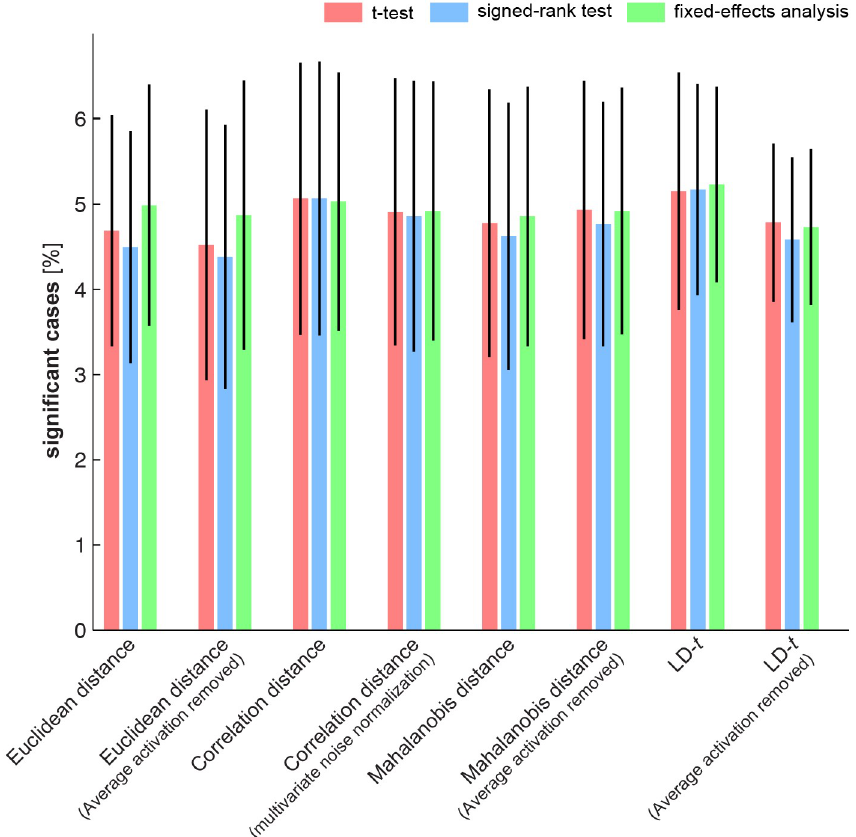
Fig 8. False-positives rates for different tests of exemplar discriminability. We estimated the false positive rate (type-I error rate) by applying tests to randomised fMRI data (simulating H 0 , see section 2.4.2 for details). The null data were simulated for a large number of iterations. At each iteration an ROI was randomly selected and data for each subject from that ROI were randomised by permuting the condition labels for a full set containing experimental conditions from both data splits. Randomisation was independently carried out for the two data splits. Under the null hypothesis, exchangeability implies that there should not be a pattern difference between replications of the same exemplar and a different exemplar. At each iteration (1,000 in total), we simulated group level data under H 0 and applied all tests to it. We then computed the average percentage of false positives (proportion of significant cases from the total number of 1,000 simulated cases, i . e . height of the bars) and their standard deviation (error bars). All tests had a false positive rate that was not significantly different from 5% after a threshold of 0.05 was applied to the tests (p > 0.5, two-sided Wilcoxon test). This means that all tests protect against false positives at an expected rate and are therefore valid.